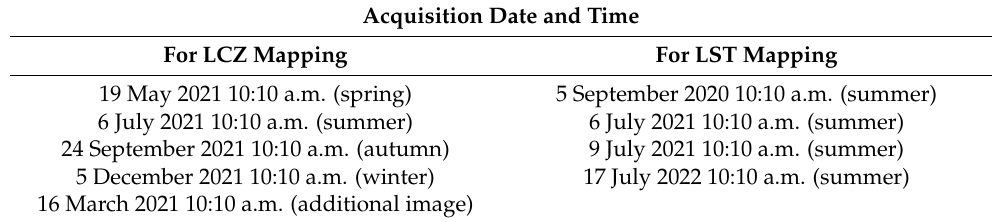
Table 1. Acquisition date and time for Landsat 8 images used for LCZ and LST mapping. Time is given in Greenwich Mean Time